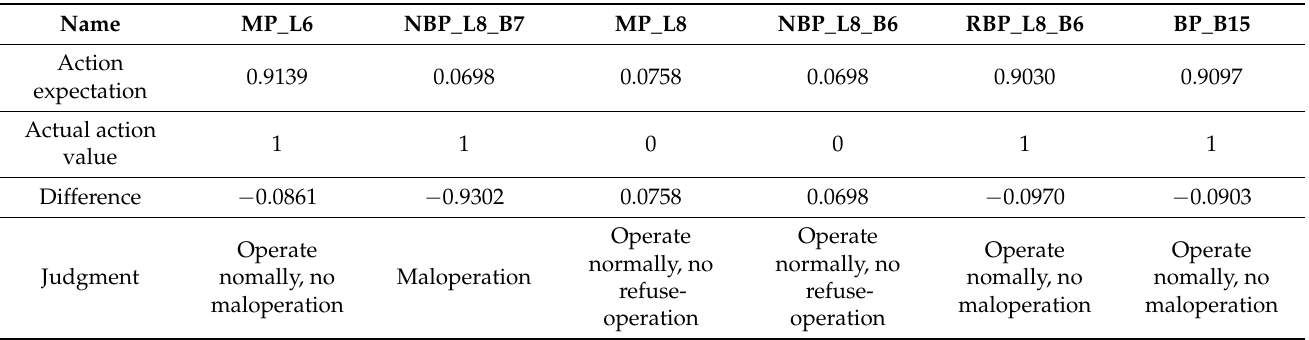
Table 9. Judgment of operation statuses of related protections.